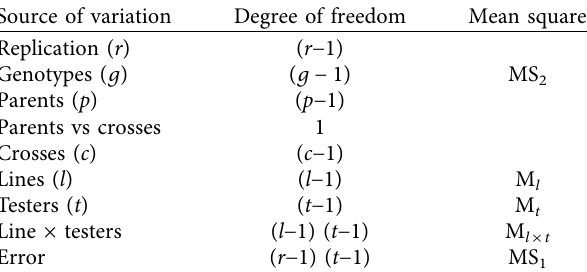
Table 1: ANOVA for line × tester